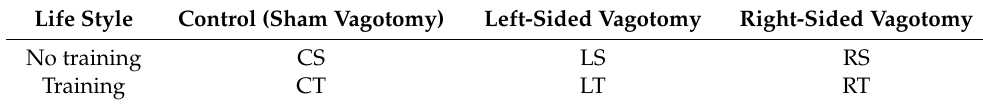
Table 1. Abbreviated designations of the animal